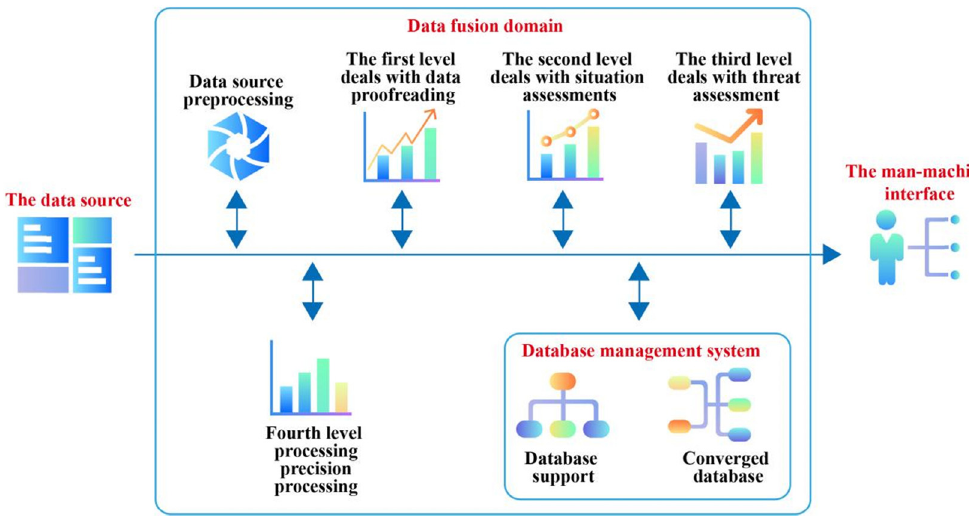
Figure 1: Data fusion